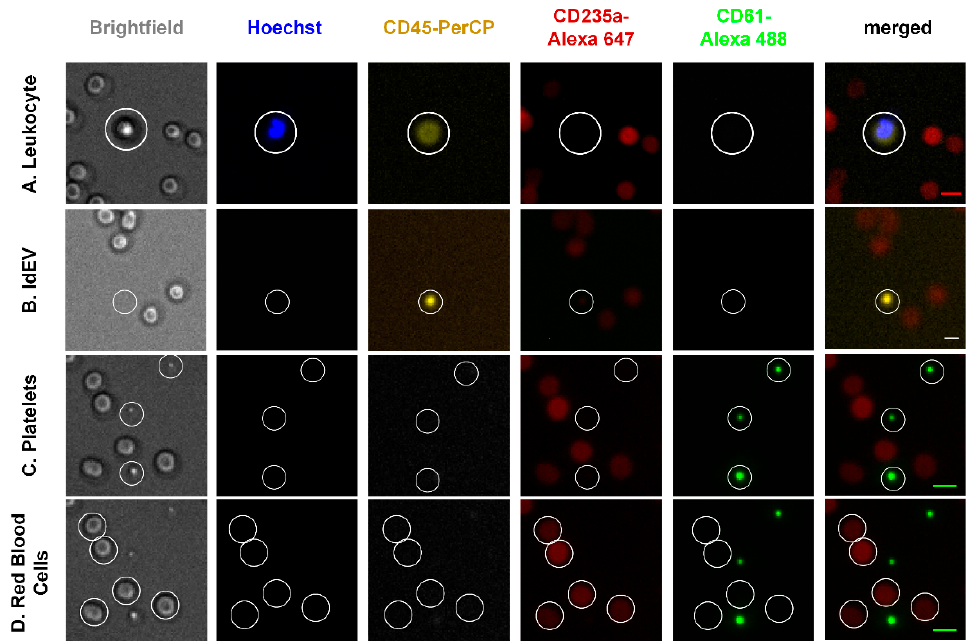
Figure 2. Bright field and immunofluorescence (IF) images of leukocytes, ldEVs, platelets and red blood cells in blood samples without EpCAM enrichment. Scale bars in the merged IF images indicate 10 μ m.